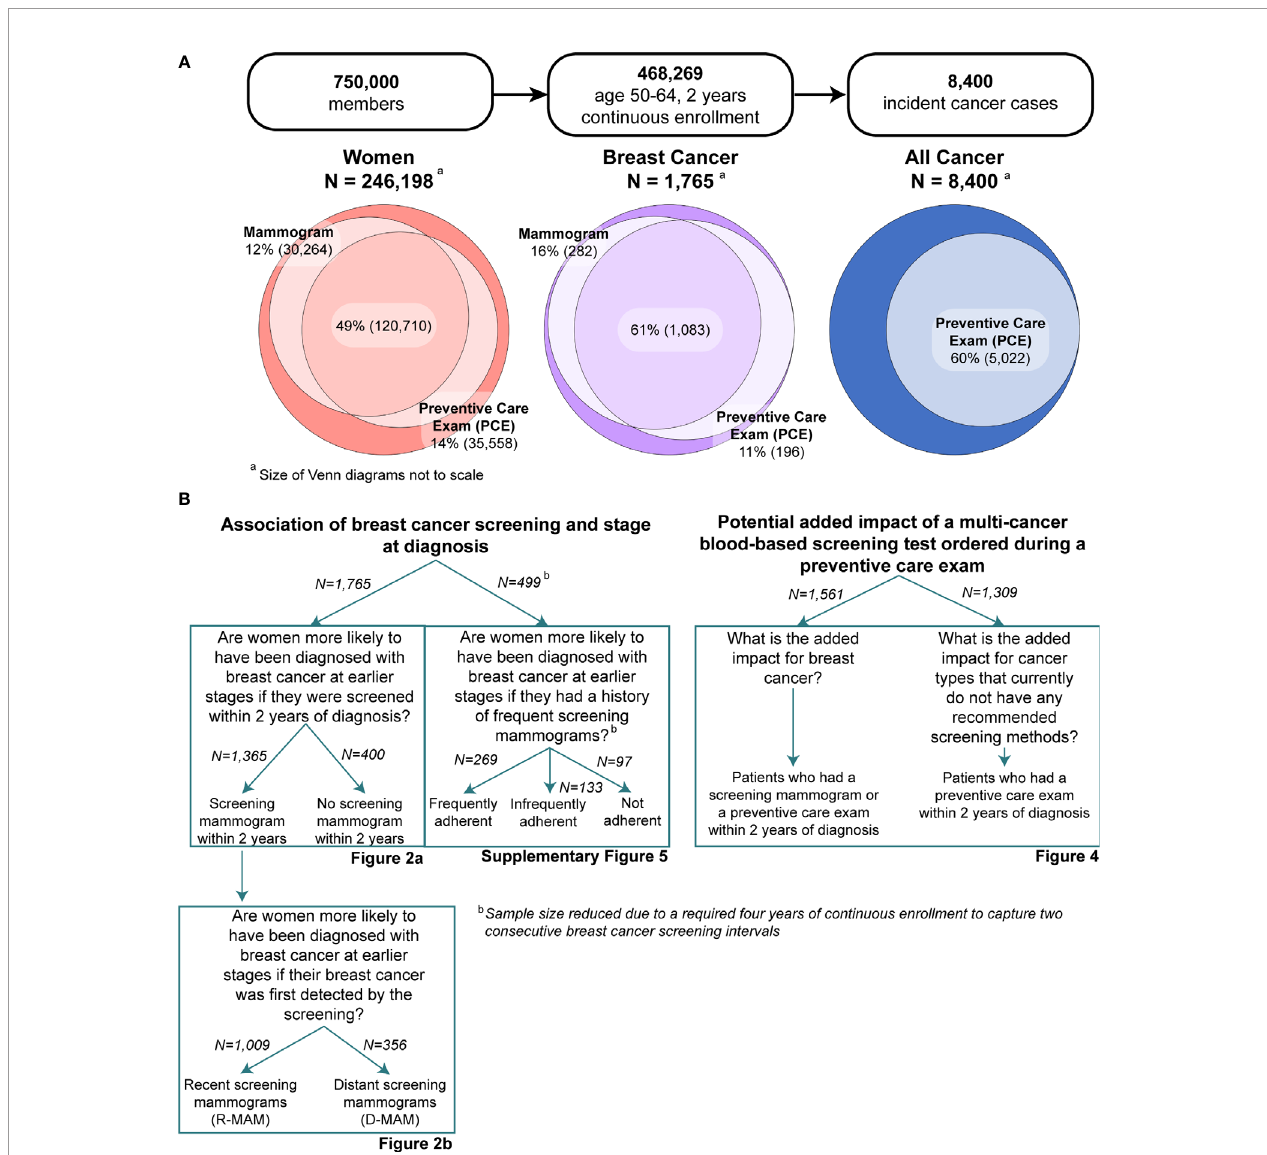
FIGURE 1 | (A) Breakdown of the study into three subpopulations: women, all cancer, and breast cancer-speci fi c populations. Inclusion criteria were ages 50-64 and at least 2 years of continuous enrollment. Screening mammogram and preventive care exam (PCE) utilization were characterized for all women and breast cancer populations, while only PCE utilization was analyzed for the all cancer (men and women) population. (B) Breakdown of the study into main aims and speci fi c research questions, along with their associated fi gures. Note that analysis on the frequency of screening mammogram history required at least four years of continuous enrollment. A description of the methods for this analysis can be found in the Supplementary Material